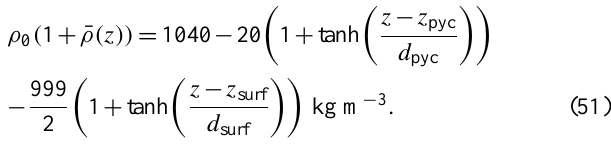
Fig. 18. Vertically integrated kinetic energy perturbation for the deep seiche cases: comparison of Boussinesq and non-Boussinesq simulations. Solid line: Boussinesq (domain between ± 30m) us- ing ρ 0 = 1000kgm − 3 . Dots: Boussinesq using ρ 0 = 1020kgm − 3 (virtually indistinguishable from solid curve). Dashed line: non- Boussinesq. (a) t = 10s. (b) t =